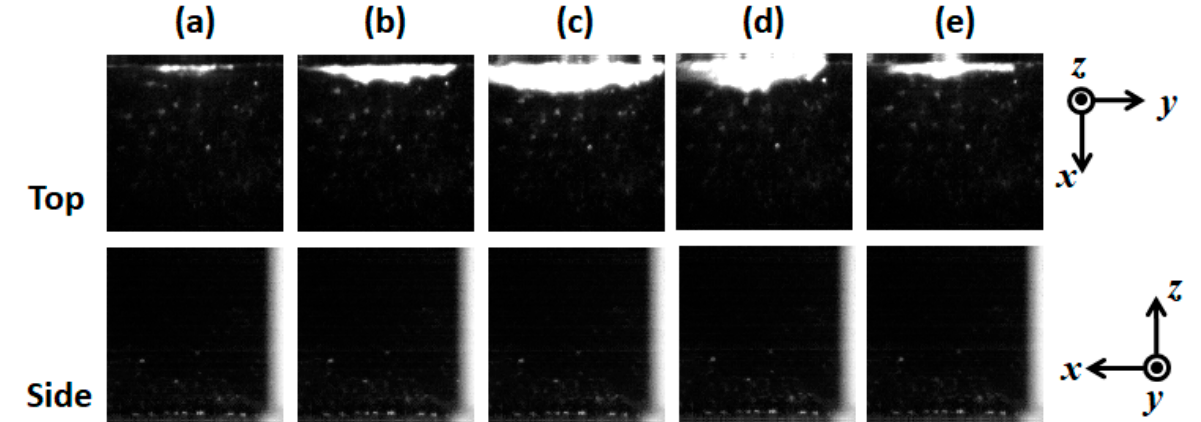
Figure 9. Instantaneous visualization using the synchronized signal with two high-speed cameras at a heat flux of 2.4 MW/m 2 : ( a ) 852.5 ms, ( b ) 852.8 ms, ( c ) 853.1 ms, ( d ) 853.3 ms, and ( e ) 853.5 ms.